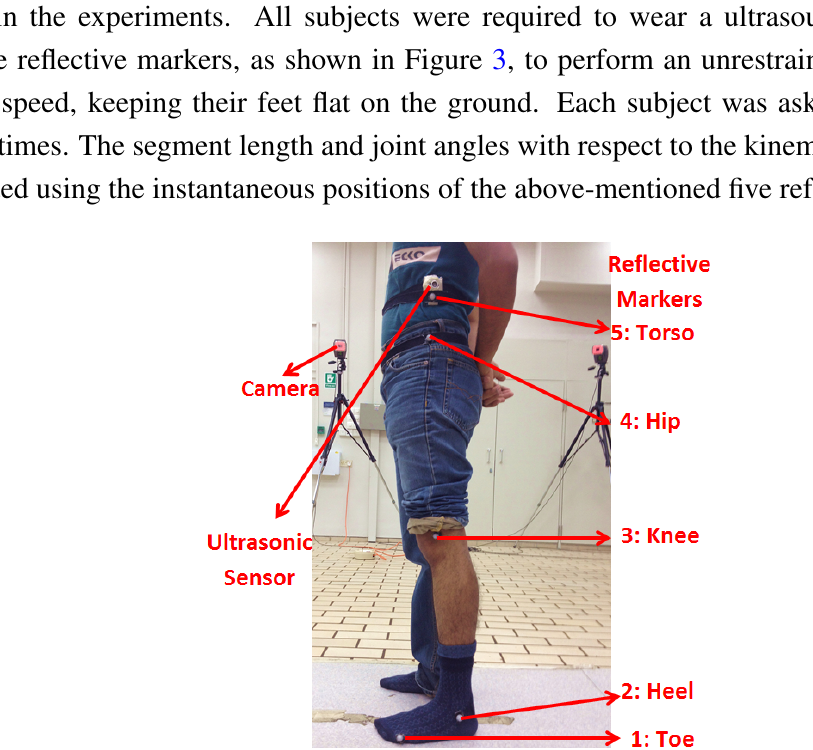
Figure 3. Wireless unit with embedded ultrasonic sensor placed on the lateral side of the trunk and five reflective markers fixed on the toe, heel, knee, hip and torso for the optical tracking reference